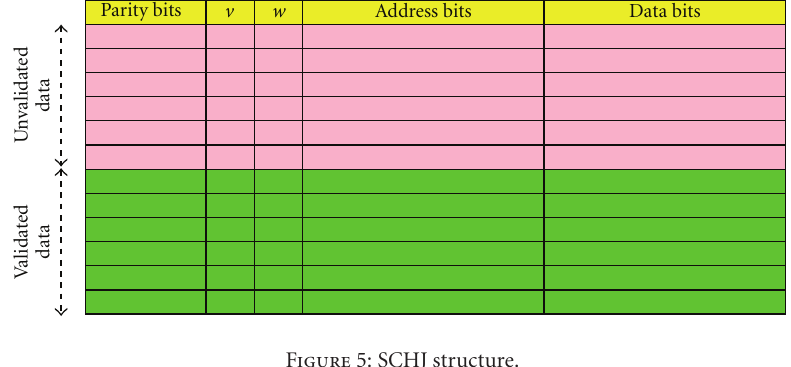
Figure 5: SCHJ structure.